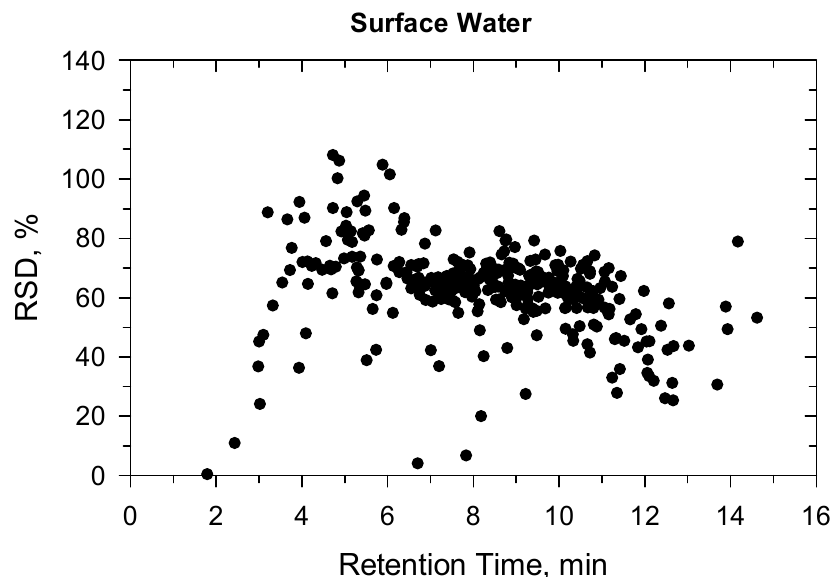
Figure 7. Recovery (%) versus retention time (min) at 10 ng/L in groundwater. Results were calcu- lated without matrix compensation.